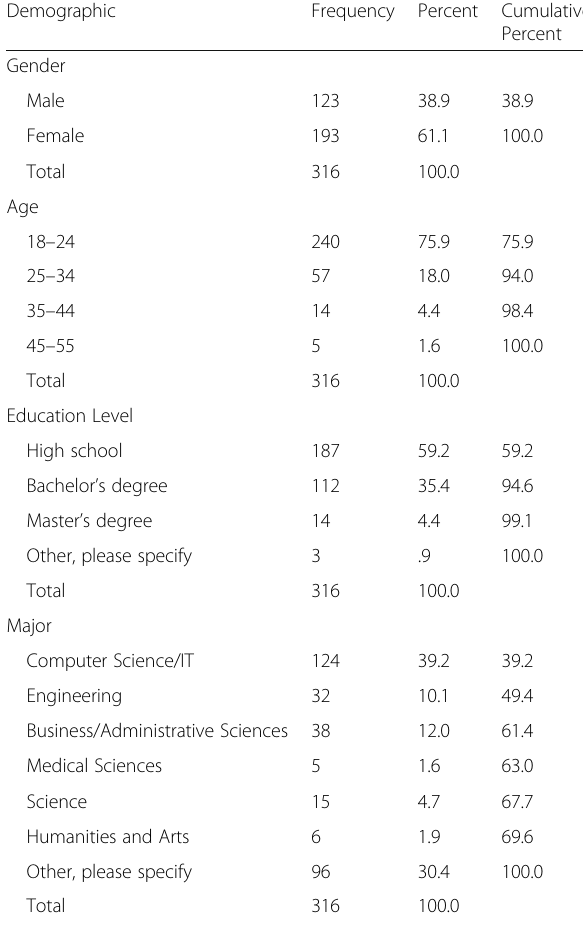
Table 1 Participants ’